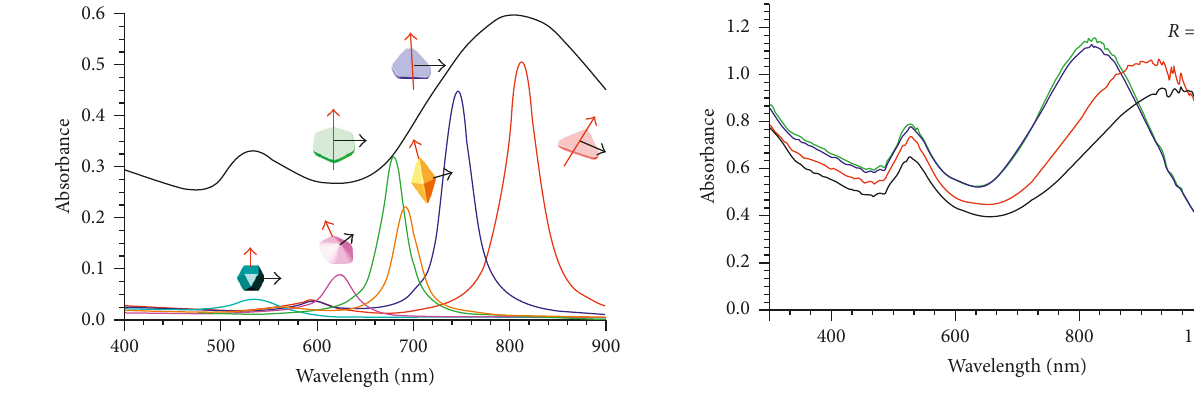
Figure 3: Simulation of the electromagnetic absorbance spectra of different species of nanoparticles that compose the experimental spectrum obtained with molar ratio R 2.74. Black arrow: direction Figure 4: Evolution of the absorbance spectra of the colloidal (cid:30) of the impinging radiation; red arrow: electric field vector. suspension with R 2.82 at different times, reported in the figure, (cid:30) after the addition of the reducing Na 2 S 2 O 3